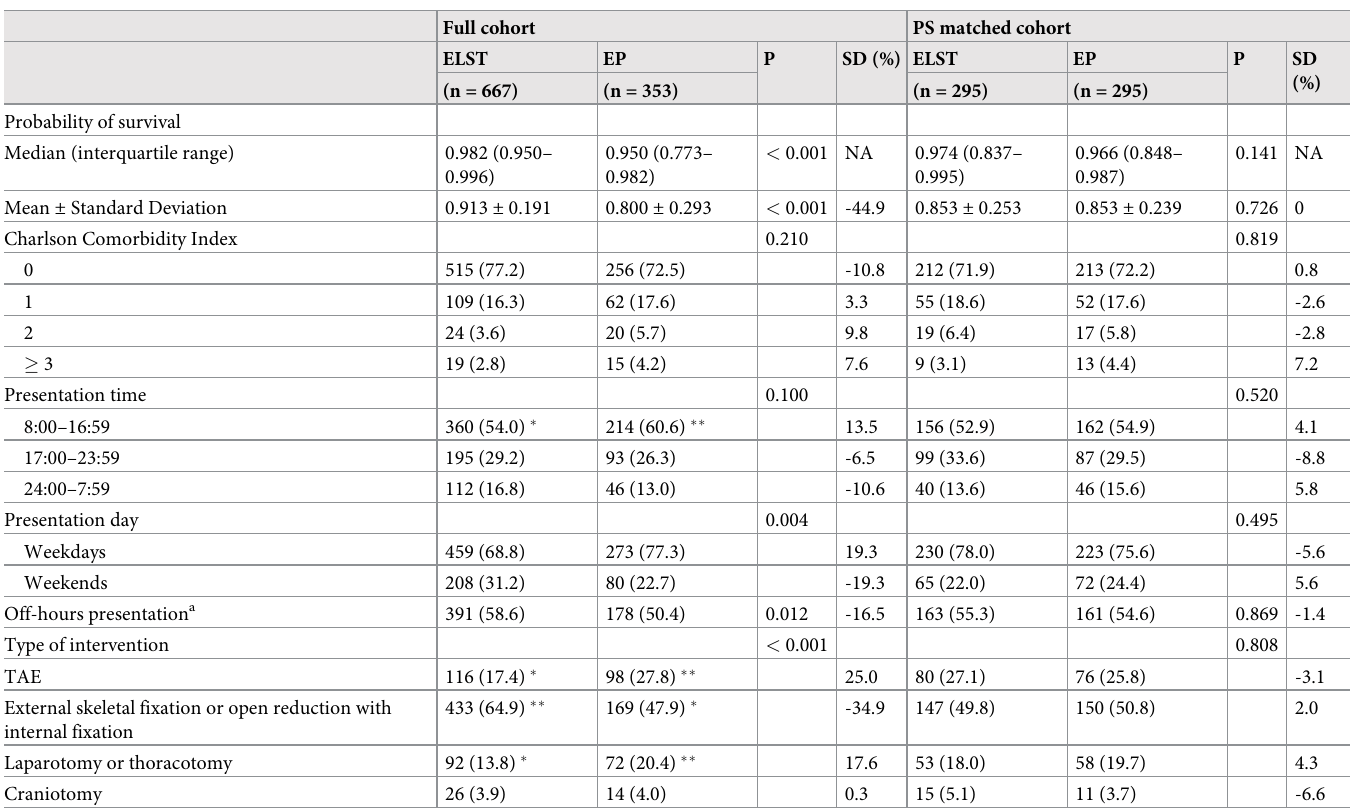
Table, injured patients who received surgery or TAE after more than 180 min (delayed inter- vention) were more likely to be transported by an EP-staffed ambulance and were more likely to present to the ED during off-hours. Conversely, the delayed intervention group was less likely to have shock (SBP � 75 mmHg) and severe torso injury (AIS � 3 injury of the abdomen or pel- vic contents) and were less likely to receive TAE and laparotomy or thoracotomy.